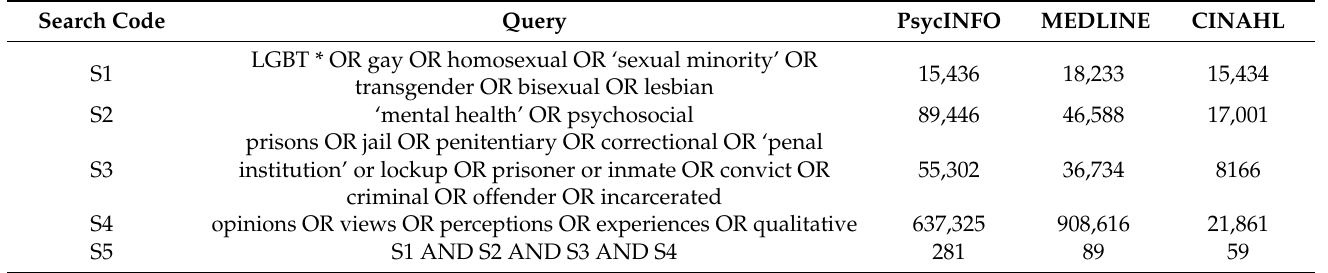
Table 1. Search results on 5th April 2021